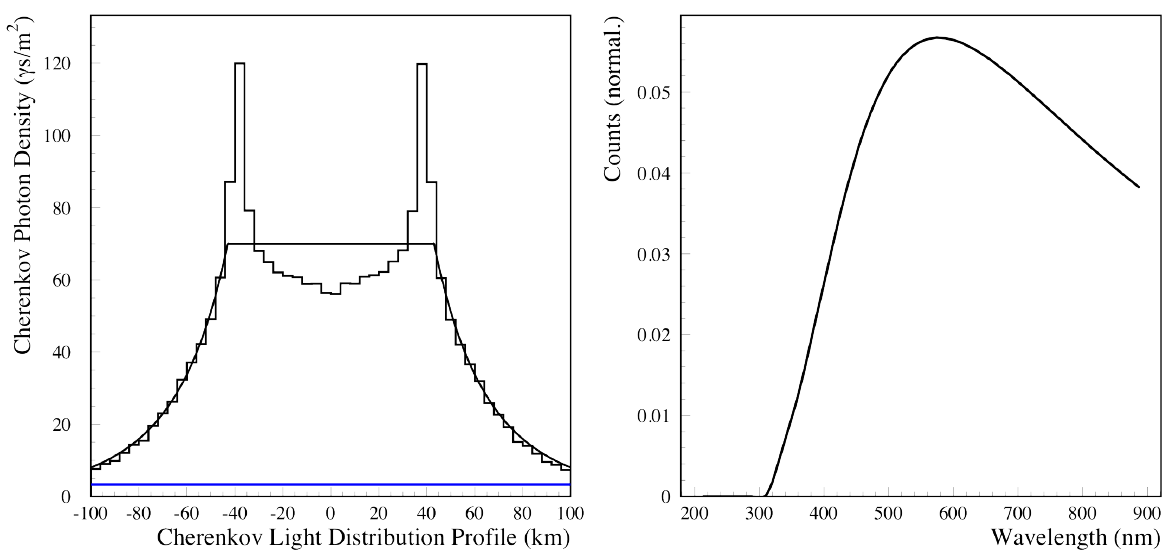
Figure 11. The spatial profile of the Cherenkov signal (photons / m 2 ) at 525 km altitude for a 100 PeV upward EAS with a 10 ◦ Earth emergence angle initiated at sea level (left) and the simulated Cherenkov spectrum observed by a POEMMA telescope for the event (right).